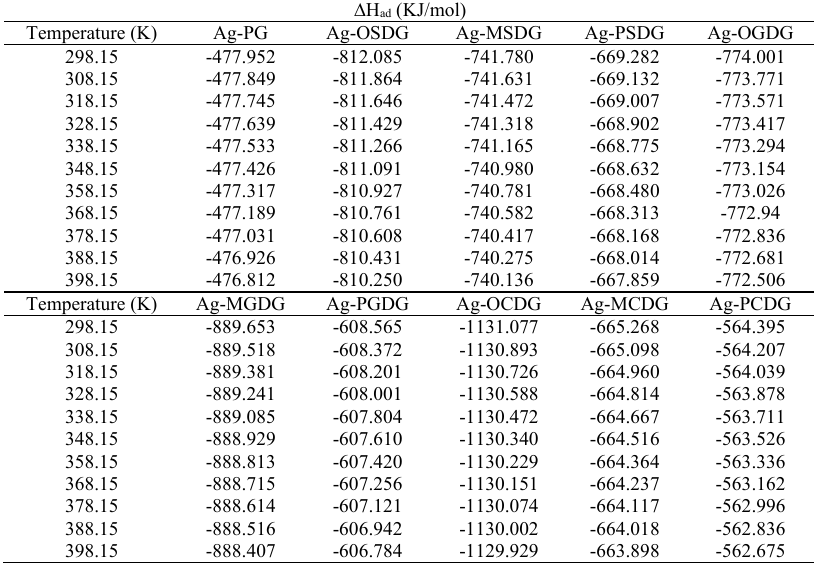
Table 2. Enthalpy changes values for the adsorption of silver (I) on the surface of ordinary and doped graphenes in the temperature range of 300- 400 K. ∆H ad (KJ/mol) Temperature